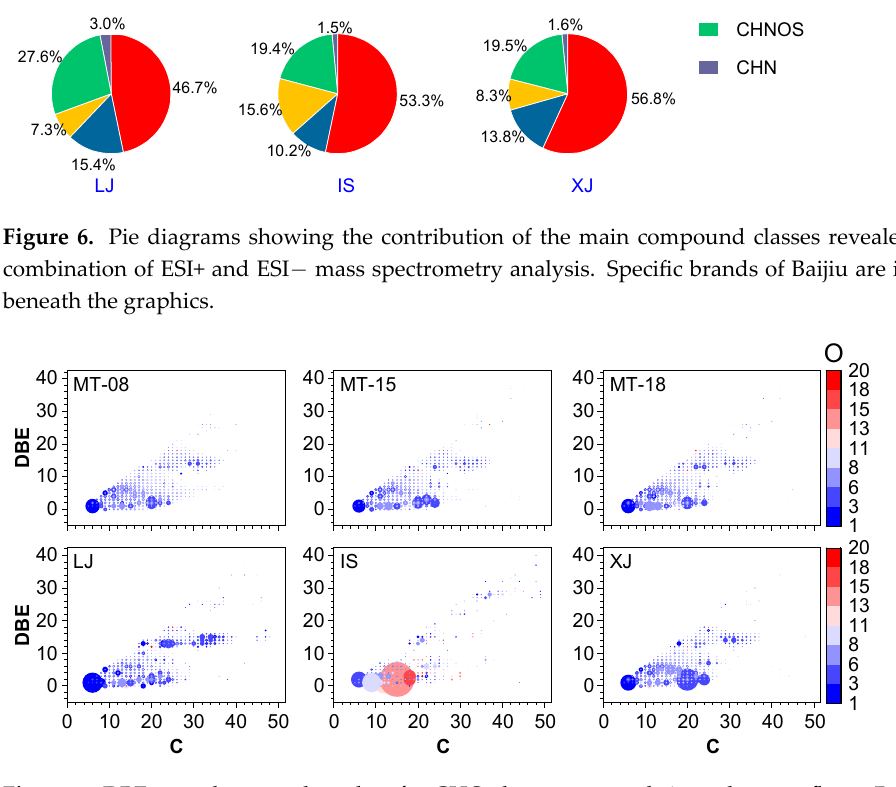
Figure 7. DBE vs carbon number plots for CHO class compounds in each sauce-flavor Baijiu. The size of the dots represents the abundance of the assigned molecular formulas. The colors represent the oxygen contents. Table 3. Specific molecular formulas with the top 10 abundance in different Baijiu samples.